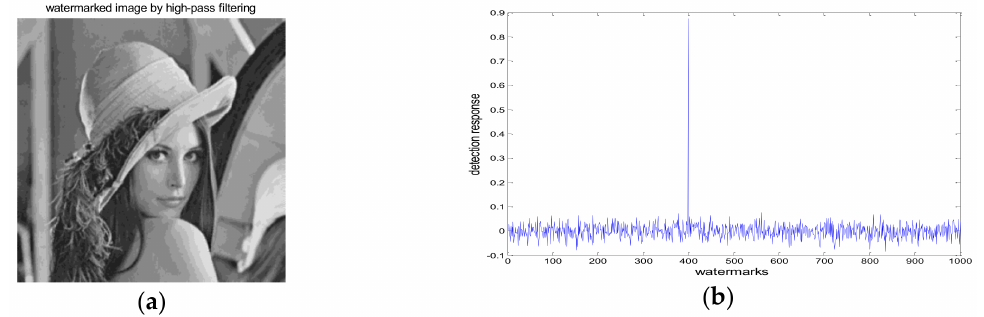
Figure 4. ( a ) High-pass filtering attack; ( b ) detector response.